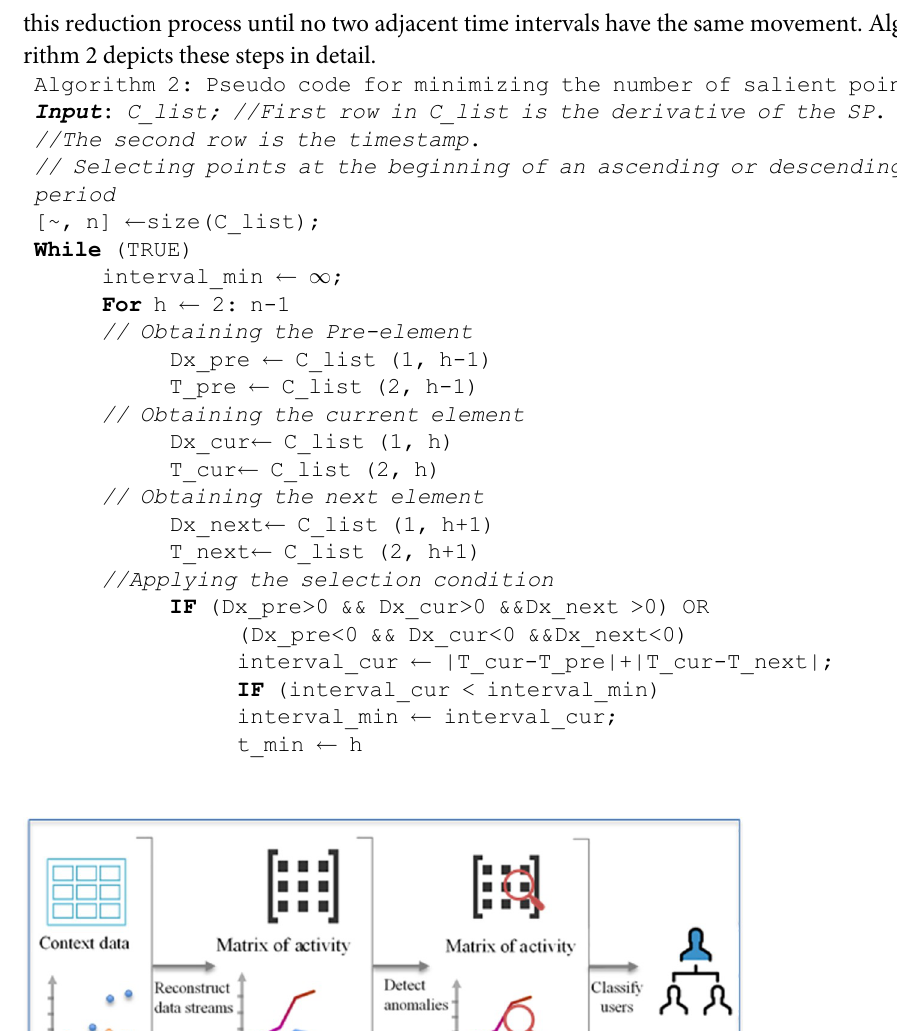
Algorithm 2: Pseudo code for minimizing the number of salient points